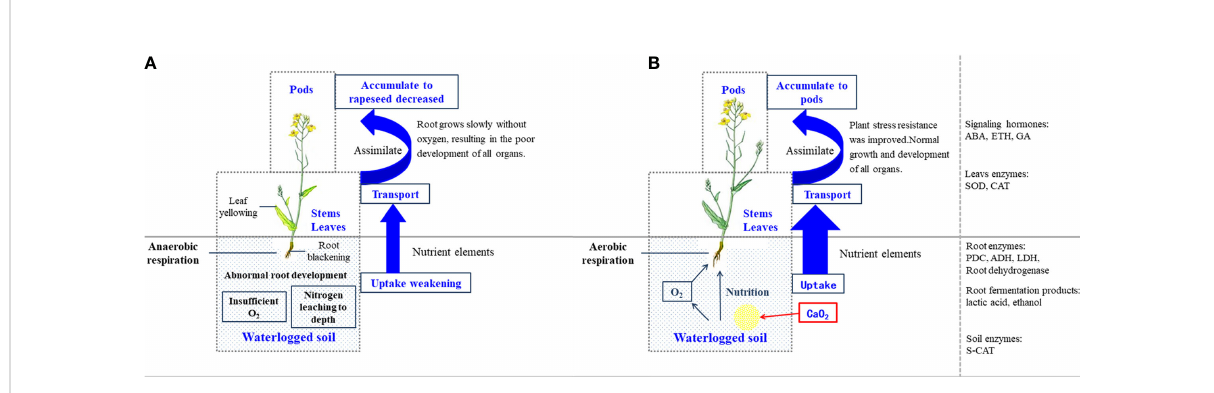
FIGURE 6 Schematic diagram of the calcium peroxide regulatory network in the regulation of rapeseed growth under waterlogging stress. (A) In waterlogging stress without calcium peroxide. (B) In waterlogging stress with calcium